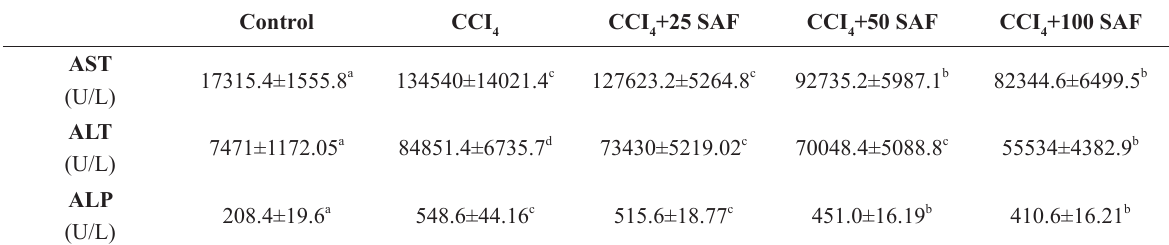
Serum liver function enzymes (AST, ALT,